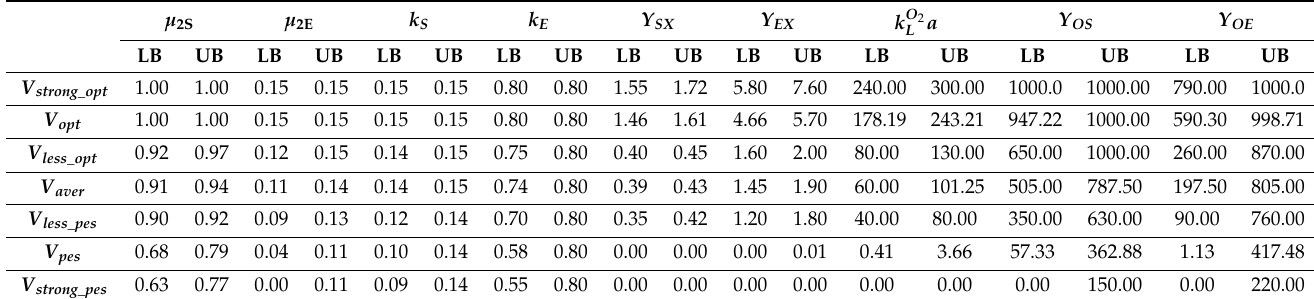
Table 4. Evaluated prognoses for MGA performance.